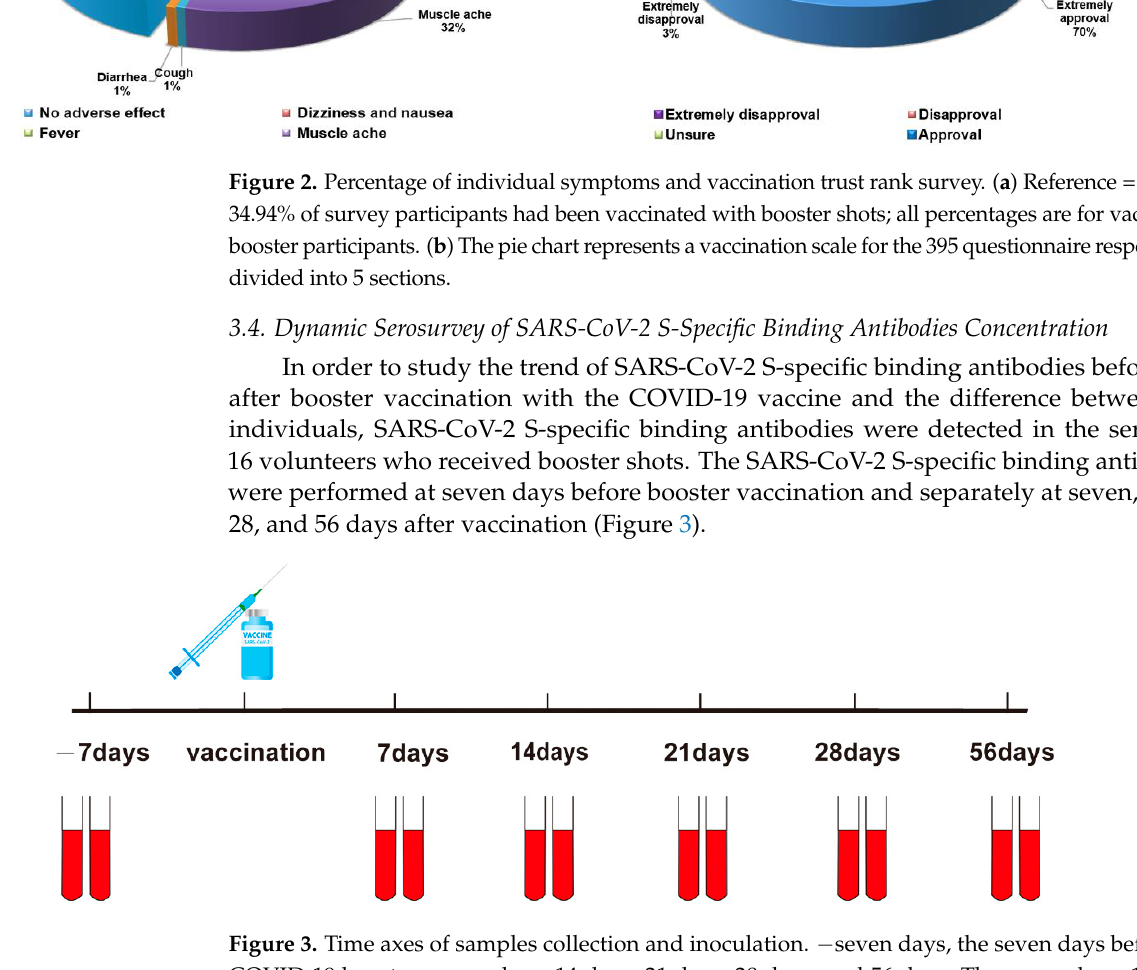
Figure 4. Antibody responses specific to SARS ‐ CoV ‐ 2 vaccination in 16 volunteers. ( a ) The scatter chart is the antibody trend chart of the six time points before and after vaccination. I Bars indicate 95% confidence intervals. ( b ) The line chart shows the trend of antibody changes in 16 volunteers at six time points before and after vaccination, respectively; Y ‐ axis values are log 10 of antibody titer values.